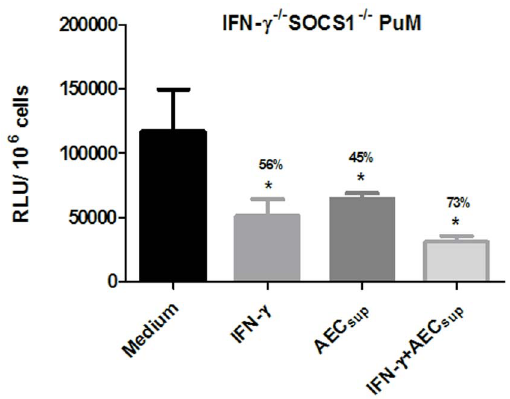
Figure 4. Impaired intracellular control of BCG growth by PuM upon IFN- c treatment is regulated by SOCS1. PuM from IFN- c -/- SOCS1 -/- mice were infected with GFP-BCG. After infection, cells were left untreated or treated with IFN- c , AEC sup and IFN- c + AEC sup for 48 h. Bacterial growth was evaluated by determining RLU. Data are shown as % reduction of phagocytosed bacteria evaluated as RLU. Values are means 6 SD of the mean of a representative experiment from 2 independent experiments with 4 replicates. The differences between groups of IFN- c -/- SOCS1 -/- PuM were analyzed using a one-way ANOVA followed by Bonferroni‘s Multiple Comparison Test. * significantly different from medium control, P , 0.05.